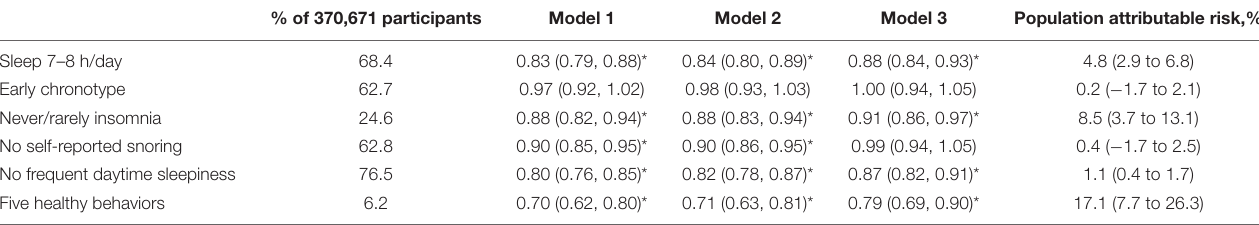
TABLE 2 | Multivariable-adjusted Odds Ratio (95% CIs) for CKD by low-risk sleep factors. % of 370,671 participants